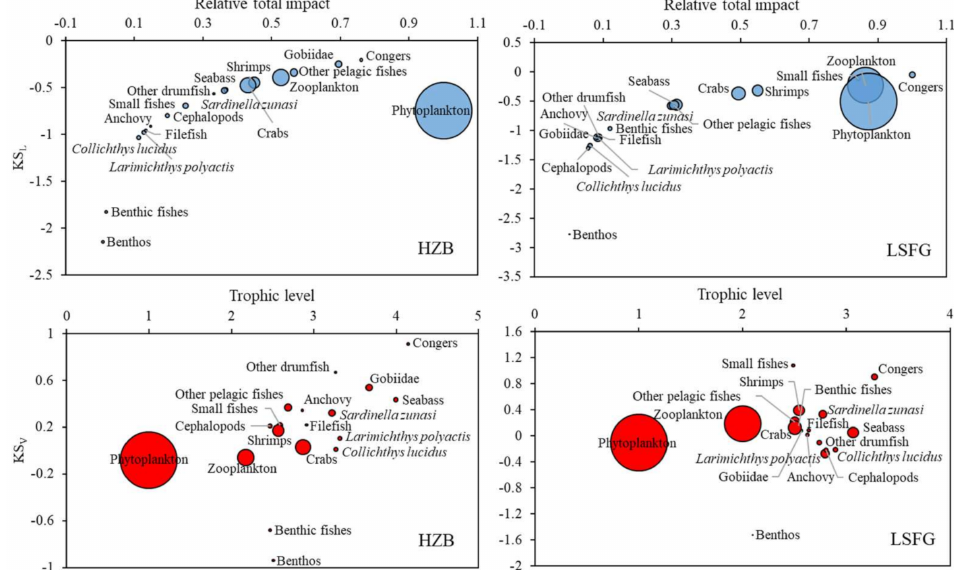
Figure 6. Relative total impact and keystone index values of functional groups in two models. KS L is from Libralato et al. (2006) [42] and KS V is from Vall et al. (2015) [43]. Circle size is proportional to